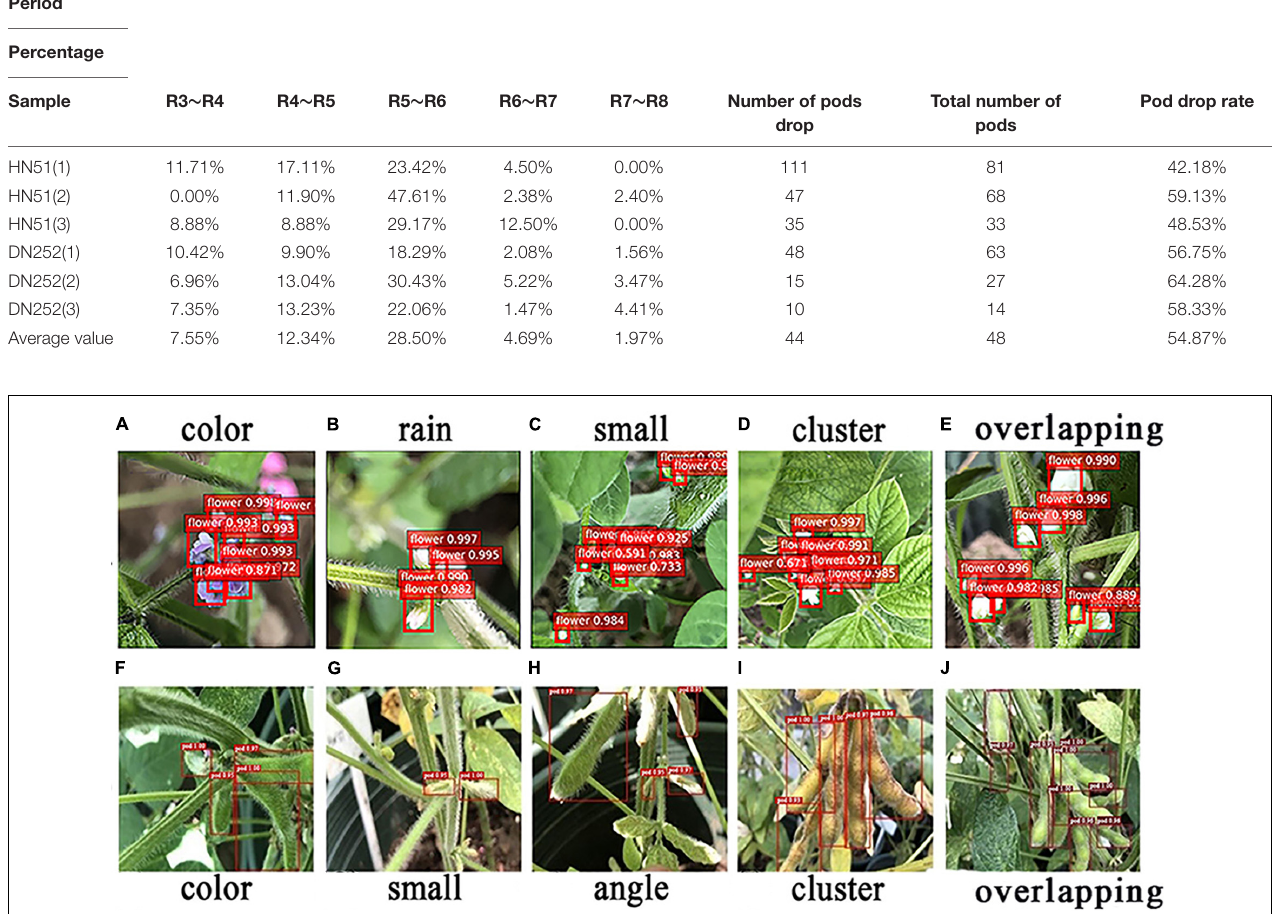
FIGURE 8 | Recognition of flowers and pods in special scenes. (A–E) Recognition of flowers in special scenes. (F–J) Recognition of pods in special